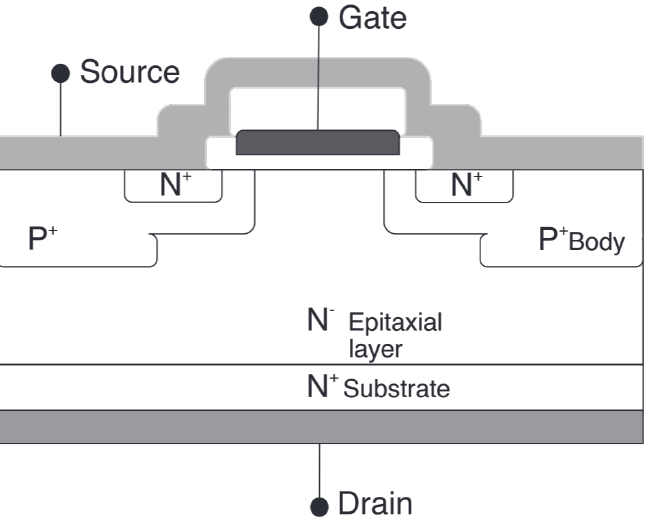
Figure 1. The structure of a power Metal Oxide Field Effect Transistors